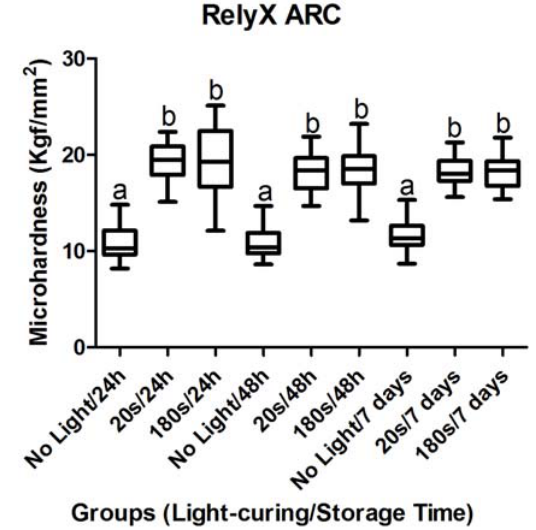
Figure 1. The mean values (Kgf/mm 2 ) were analyzed according to exposure time of light-curing and storage time for RelyX ARC. Different letters (A–B) indicate statistically significant difference at 5% level (Tukey’s test; P < 0.05).